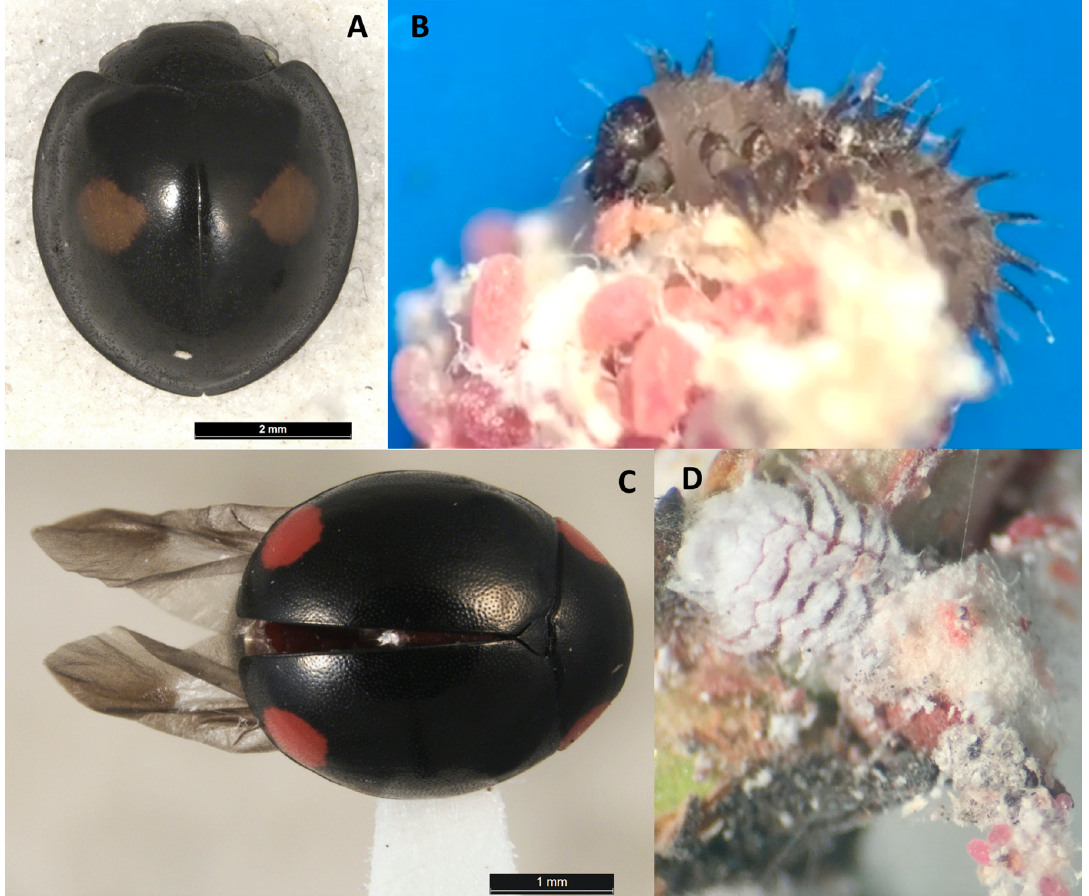
Figure 4. Predators of Acanthococcus lagerstroemiae found in Louisiana: ( A ) Adult of Chilocorus cacti ; ( B ) Larva of Chilocorus cacti feeding on eggs of Acanthococcus lagerstroemiae ; ( C ) Adult of Hyperaspis bigeminata ; and ( D ) Larva of Hyperaspis bigeminata feeding on eggs of Acanthococcus lagerstroemiae . Voucher specimens of these two ladybeetles were deposited in Louisiana State Arthropod Museum at Louisiana State University.